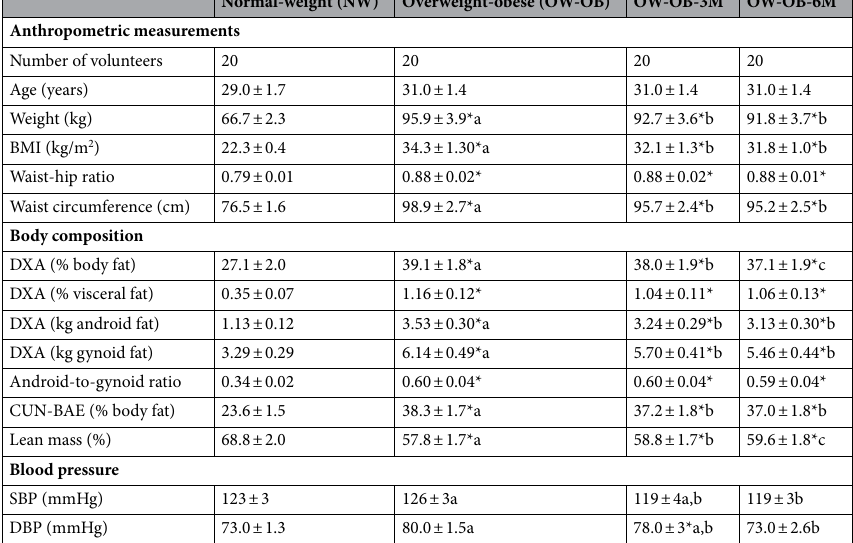
Normal-weight (NW) Overweight-obese (OW-OB) OW-OB-3M